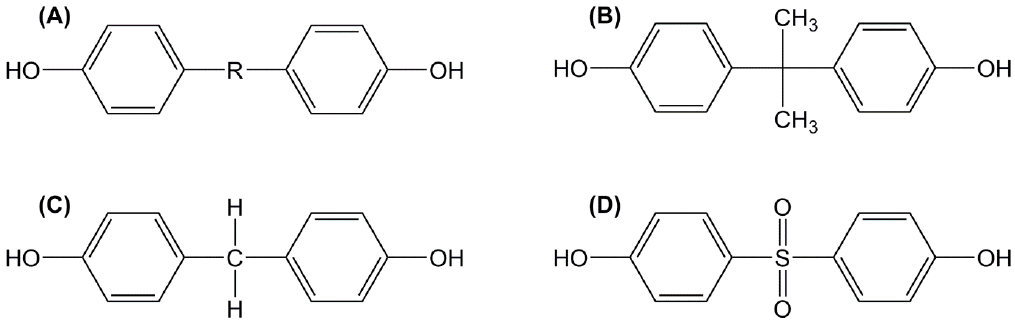
Figure 2. Chemical structures of bisphenol analogues ( A ); bisphenol A ( B ); bisphenol F ( C ) and bisphenol S ( D ).